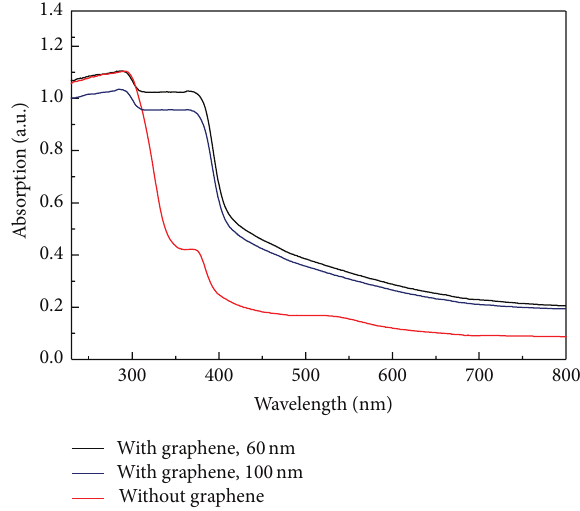
Figure 2: Absorbance spectra of the DSSCs with and without the graphene electron transfer layer.